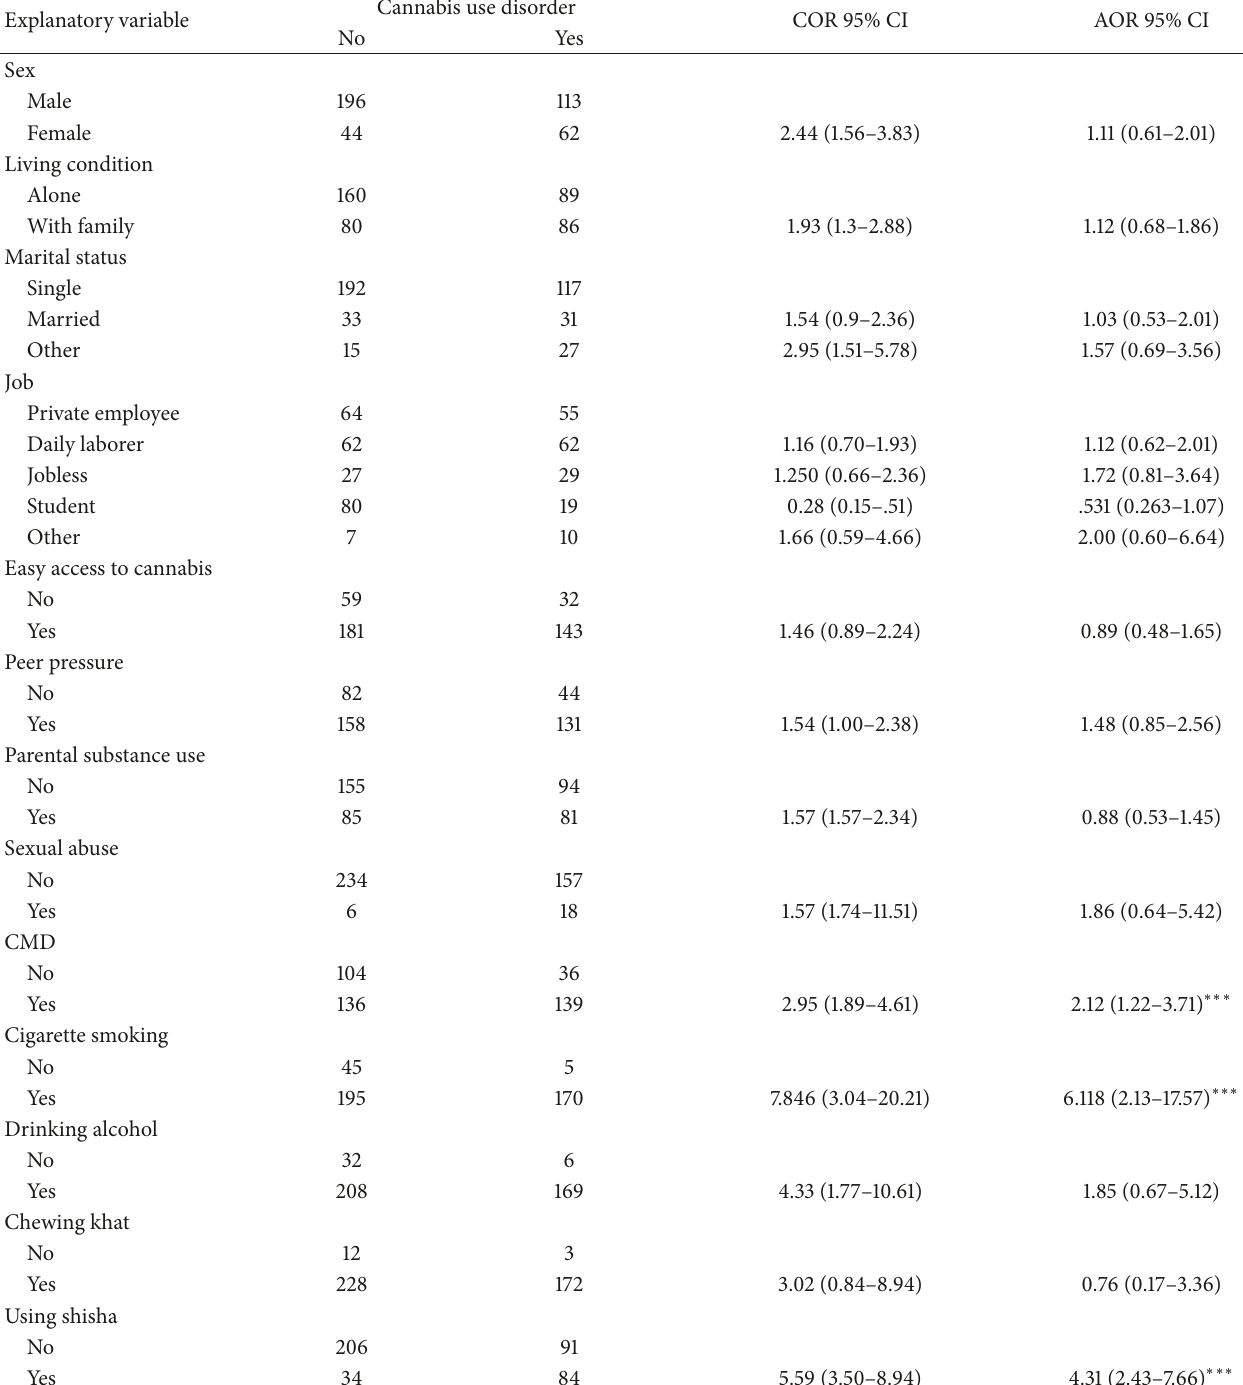
Table 4: Multivariate logistic regression analysis results of factors associated with cannabis dependence among young adults at Shashemene Town, Oromia Region, Ethiopia